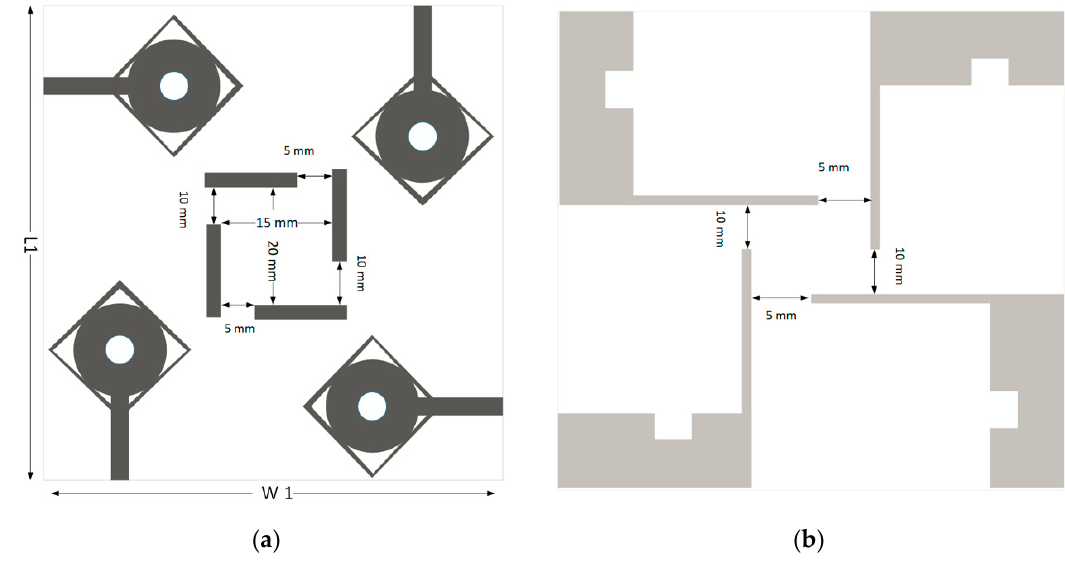
Figure 7. MIMO SWB antenna. ( a ) Radiation patch and ( b ) ground plane.